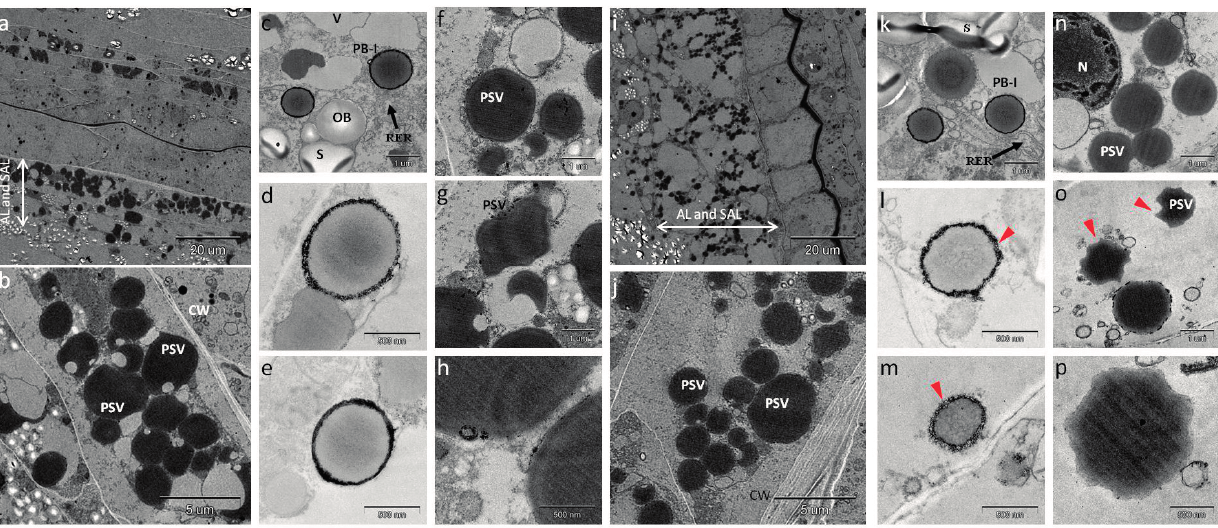
Figure 6. Phenotypic characterization of seed storage organelles. TEM was used to observe the protein bodies in developing seeds of wild type ( a – h ) and Glb-RNAi transformants ( i – p ). Scale bar is shown in each panel. AL, aleurone layer; SAL, subaleurone layer; CW, cell wall; V, vacuole; S, starch grain; OB, oil body; N, nucleus; PB-I, protein body I; PSV, protein storage vacuole; and RER, rough endoplasmic reticulum. Red arrowheads, distinguished outline and shape compared with those of wild